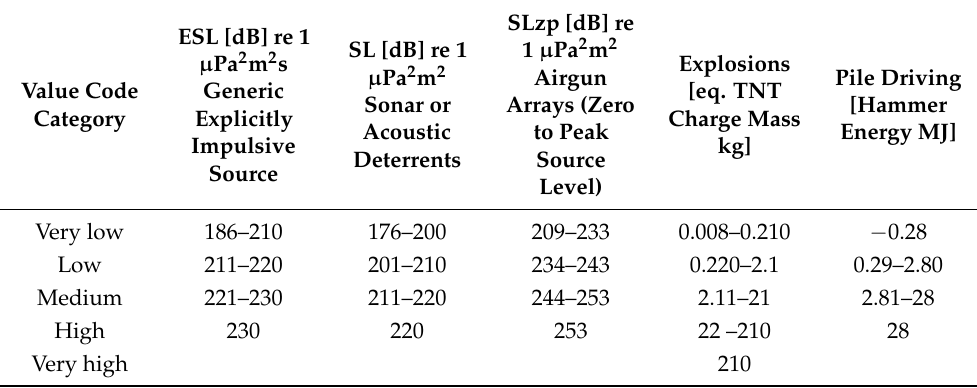
Table 2. Categorization of specific source levels and associated physical quantities into classes as proposed by TG Noise with data from